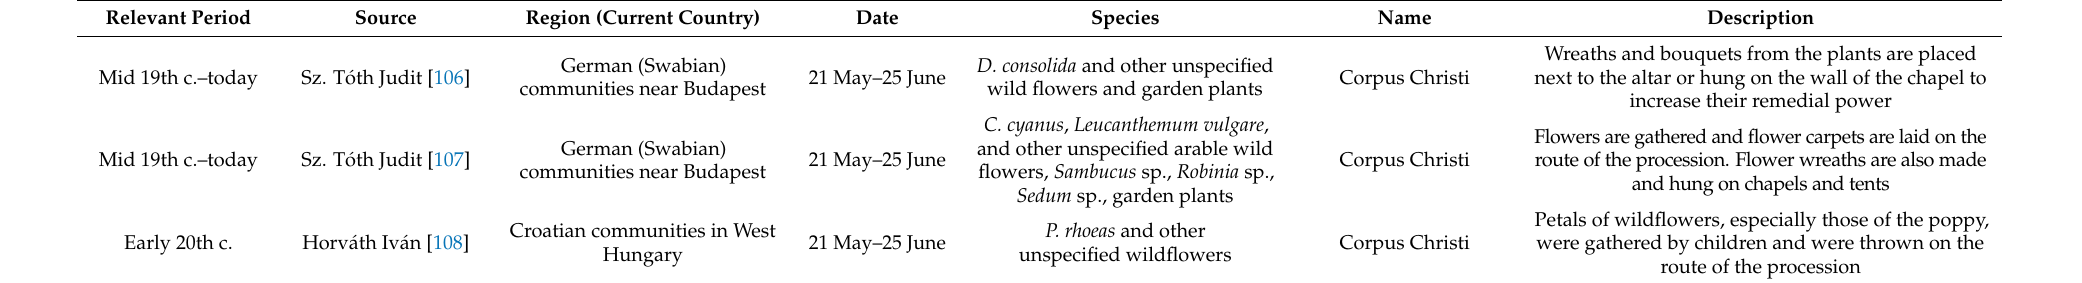
Table 3. Records on the uses of arable wildflowers in religious ceremonies from the mid-19th century in the Carpathian